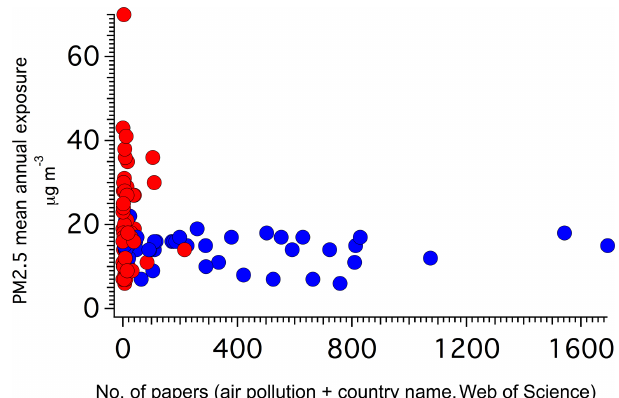
Figure 1. Africa (red) and Europe (blue), PM 2 . 5 mean an- nual exposure (https://data.worldbank.org/indicator/en.atm.pm25. mc.m3, last access: 17 January 2018) and paper count of country + air pollution (from Web of